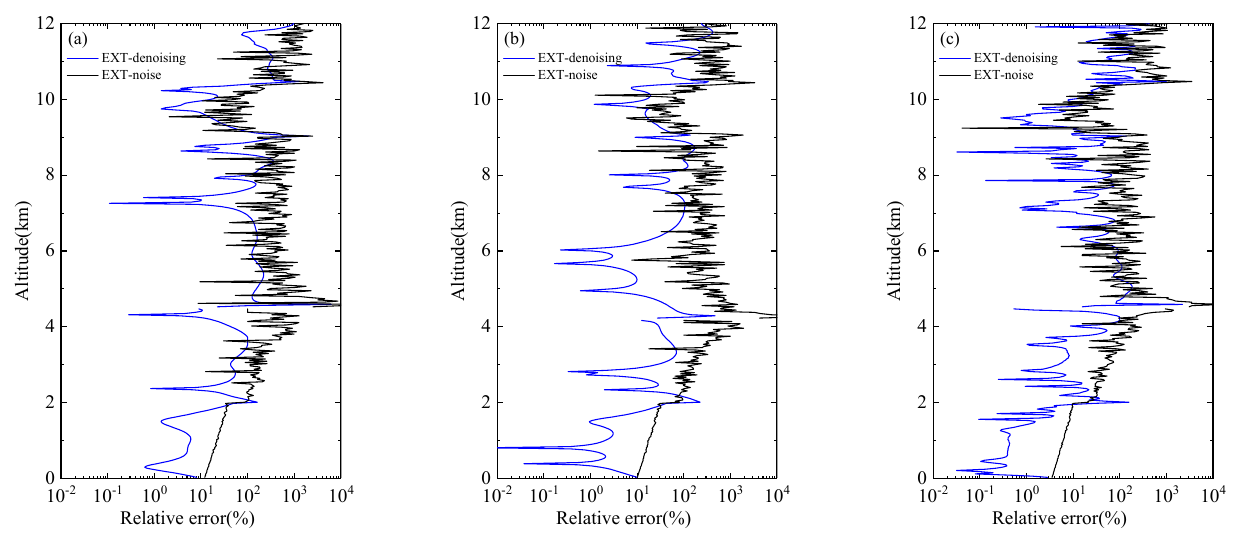
Figure 9. Comparison of relative error of extinction coefficient before and after denoising (with